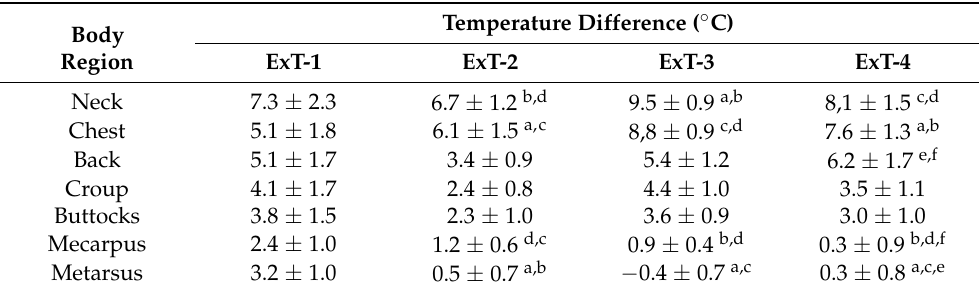
Table 5. Heating of the examined regions after exercise (differences between absolute body surface temperatures before and after exercise in tests 1 to 4 (ExT-1 to ExT-4)). Temperature Difference ( ◦ C) Body Region ExT-1 ExT-2 ExT-3 ExT-4 Neck 7.3 ± 2.3 Chest